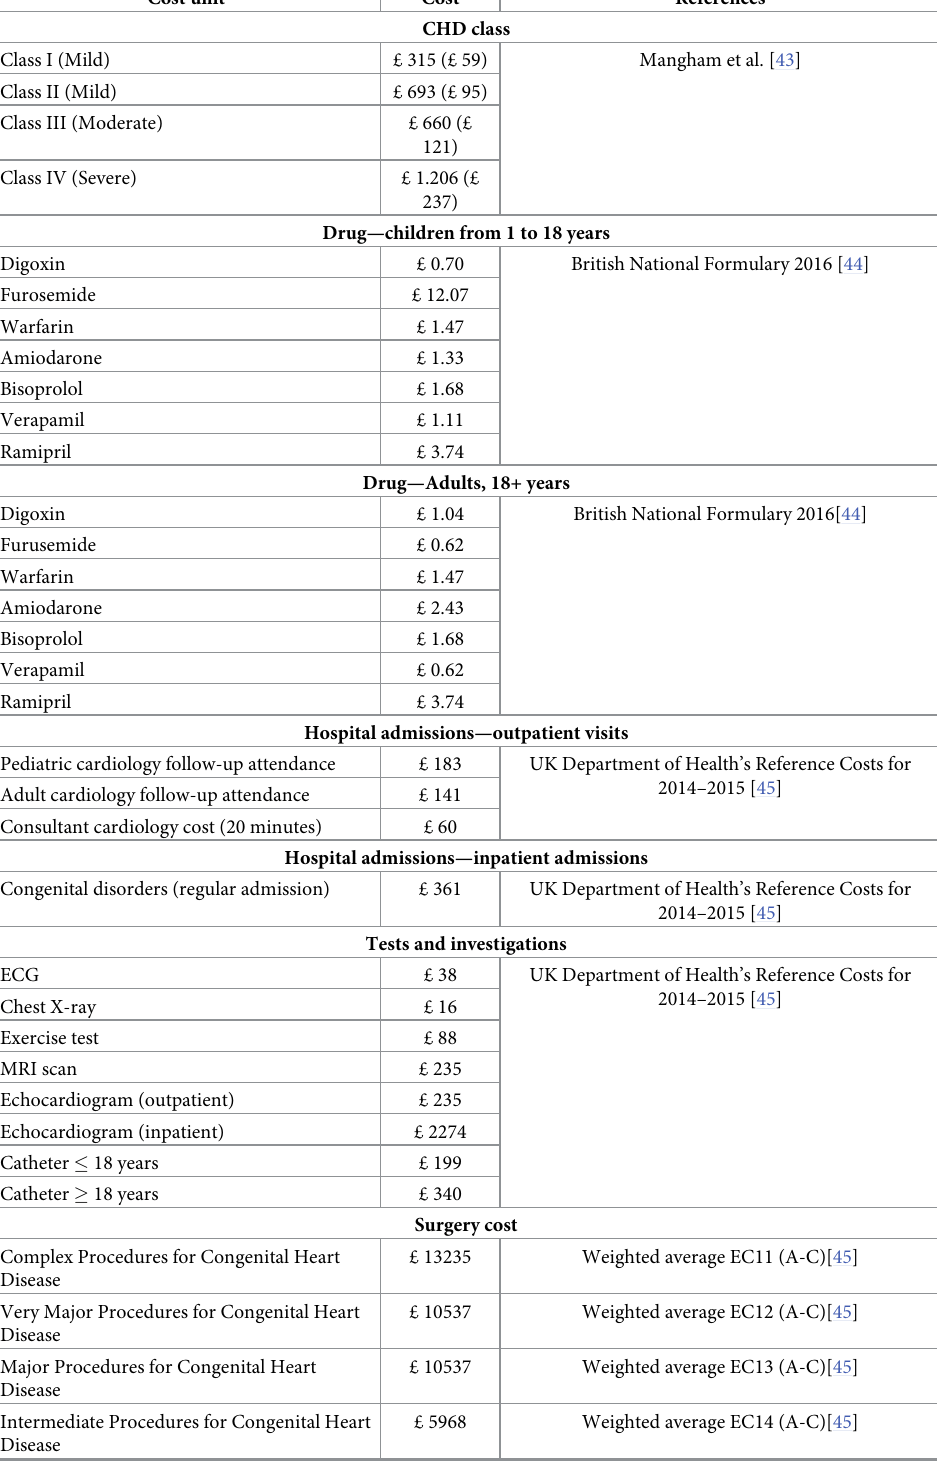
Table 9. Unit costs for resource use and cost of index surgery and